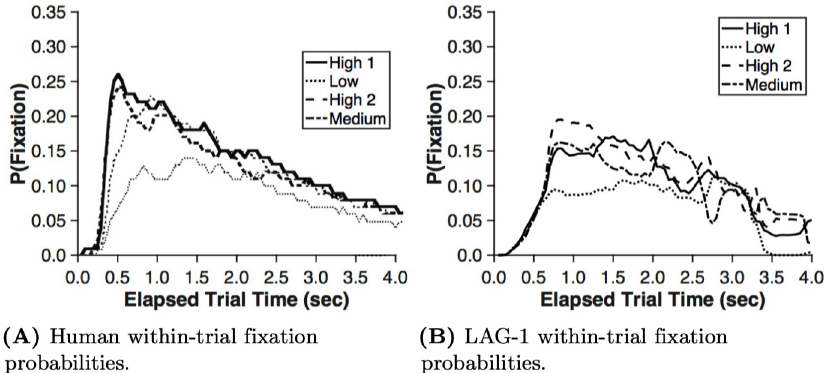
Fig 13. Saccadic timing neurons. Two examples of the contemporaneous activity of the three neurons of the Saccade Timing System, at two different points in learning. A) Before the model has made any strong feature-category associations, different stimulus features are equally interesting to it. Because there is little preference for particular features at this point, competition to determine the next saccade target takes longer to resolve than later in the experiment, extending the fixation duration in time. In these cases, the Gaze Change Neuron (blue) eventually surpasses the Fixation Neuron (red), just prior to the phasic spike in activity of the Saccade Initiation Neuron (black) which initiates a saccade. B) After the model has established stronger associations between features and categories, the knowledge that particular feature locations contain useful information, speeds targeting by boosting priority at these locations in the Spatial Attention Field. This is reflected in the modified timing relationships of the three neurons, where the Gaze Change Neuron does not reach the same level as the Fixation Neuron before the Saccade Initiation Neuron spikes. As a result, fixation durations are 30–40 ms faster than at the start of the experiment.